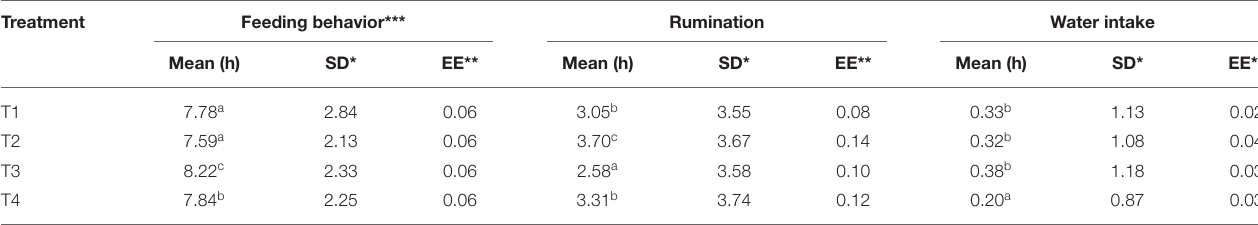
TABLE 7 | Time spent in different feeding behavior. Treatment Feeding behavior*** Rumination Water